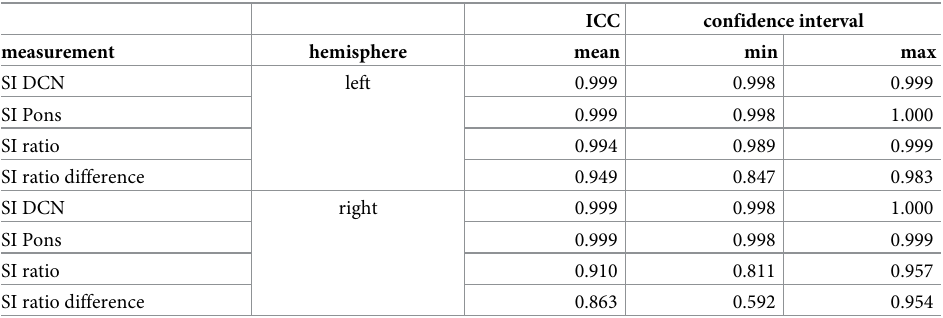
Table 4. Intraclass-correlation coefficient (ICC).